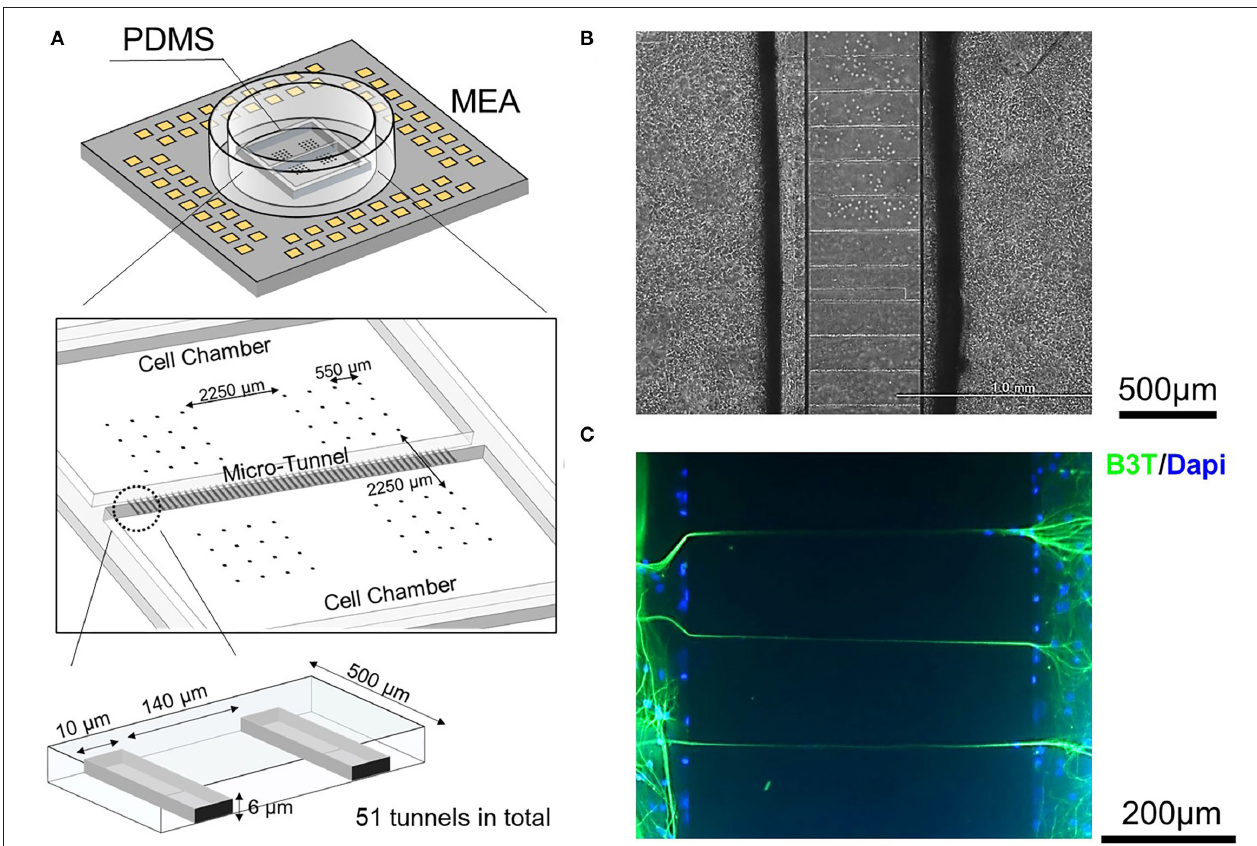
FIGURE 1 | Design of the hippocampal (HPC)-neocortical (CX) coculture device and confirmation of micro-tunnel function. (A) A schematic of the chamber/micro-tunnel structure fabricated from polydimethylsiloxane (PDMS) combined with the micro-electrode array (MEA) substrate. The two cell-culture compartments are connected by 51 micro-tunnels to allow inter-network communication. (B) Micro-tunnels were observed by phase-contrast microscopy. (C) Micro-tunnel function confirmed by immunocytochemistry. The presence of axons in the micro-tunnels after culturing is confirmed by Beta III Tubulin (B3T) immunopositivity, shown in green. Nuclei are stained with DAPI and appear in blue in the figure. The dimensions of the micro-tunnels were chosen to allow the passage of axons while preventing the entrance of cell